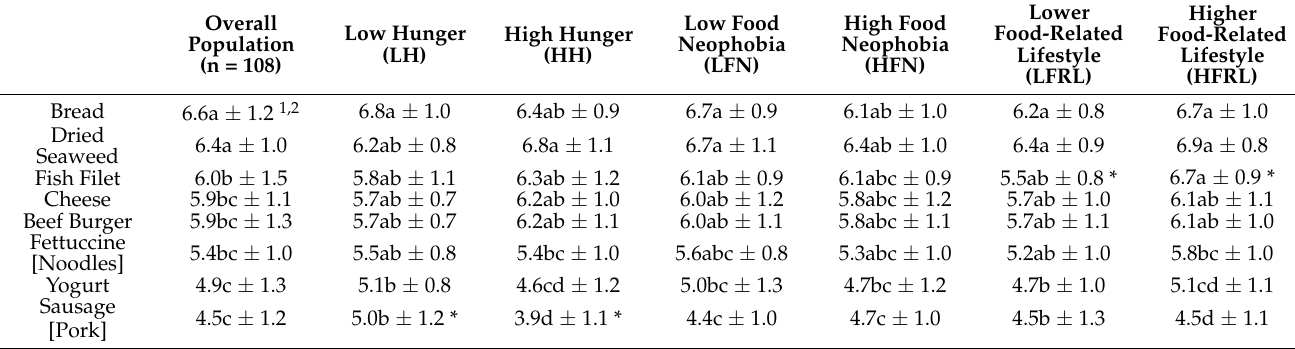
Table 1. Consumer mean ( ± standard deviation) purchase-intent scores for the different food